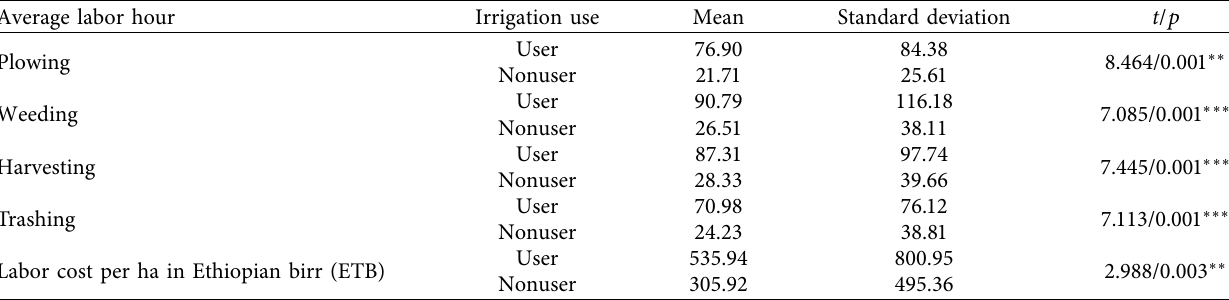
Table 5: Labor hour and cost of irrigation use.